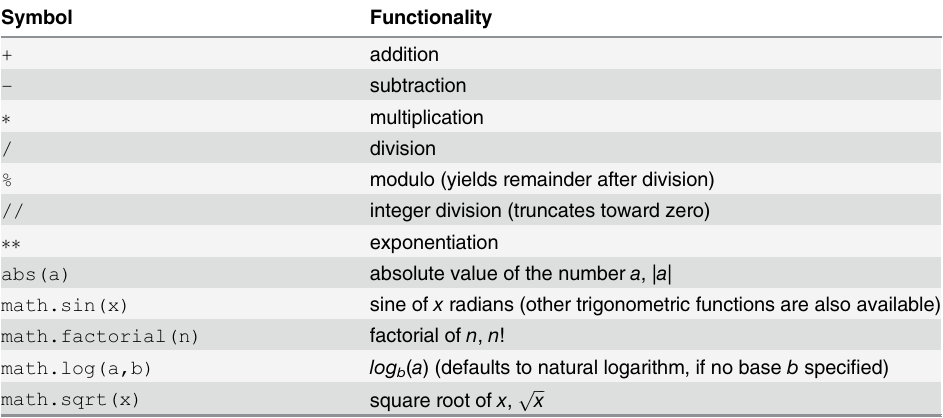
Table 2. Common mathematical operators in